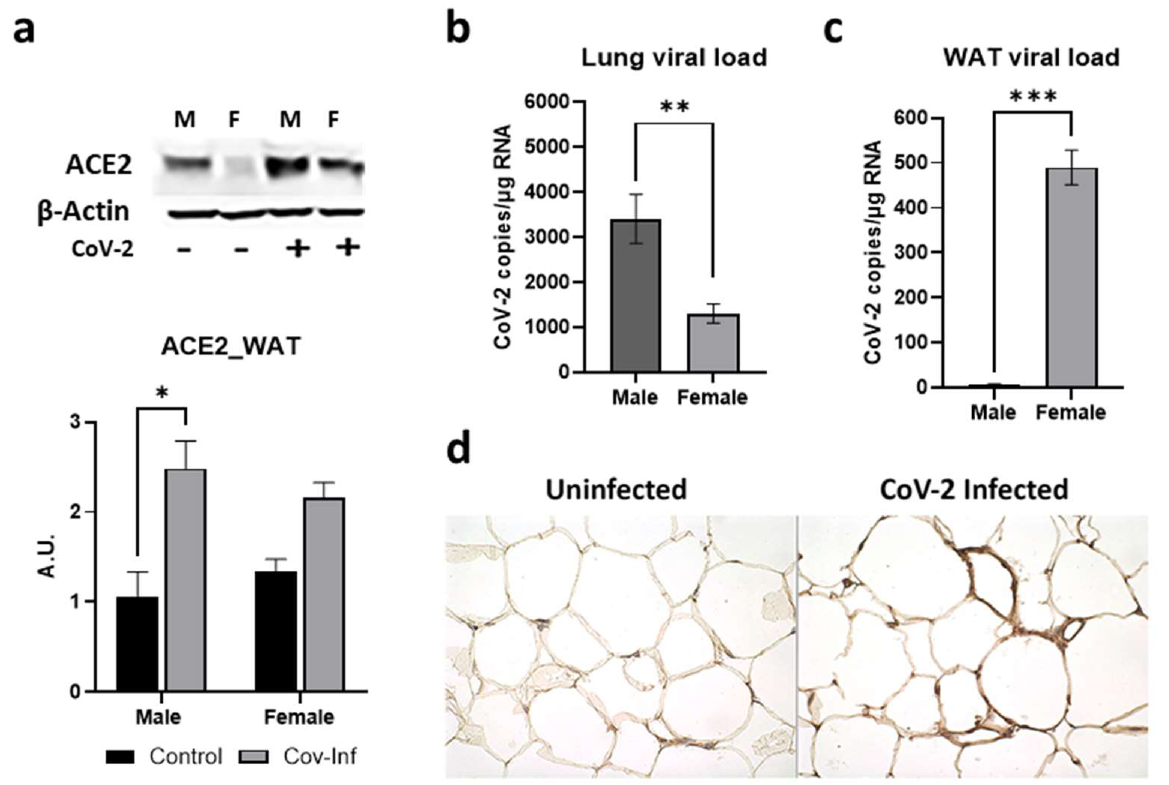
Figure 2. Alterations in ACE2 levels and SARS-CoV-2 viral load in the WAT of male and female CoV-2 infected mice. ( a ) Immunoblot analysis of ACE2 in WAT (top). β -Actin was used as loading control. Fold changes in the protein levels of ACE2 were normalized to β -Actin expression and is shown as a bar graph (bottom). The error bars represent standard error of the mean. * p < 0.05 compared to uninfected sex-matched mice ( n = 4/sex/group) (M, male; F, female); Real-Time PCR analysis showing the number of CoV-2 viral copies/ µ g of RNA in the ( b ) lungs and ( c ) WATs of male and female CoV-2 infected mice. The error bars represent standard error of the mean (** p ≤ 0.01 and *** p ≤ 0.001); ( d ) IHC staining of anti-SARS-CoV-2 nucleocapsid protein showing the presence of CoV-2 in adipose tissue around the lipid droplets of infected female hACE2 mice ( n = 4 mice, a minimum number of five images/section were analyzed).